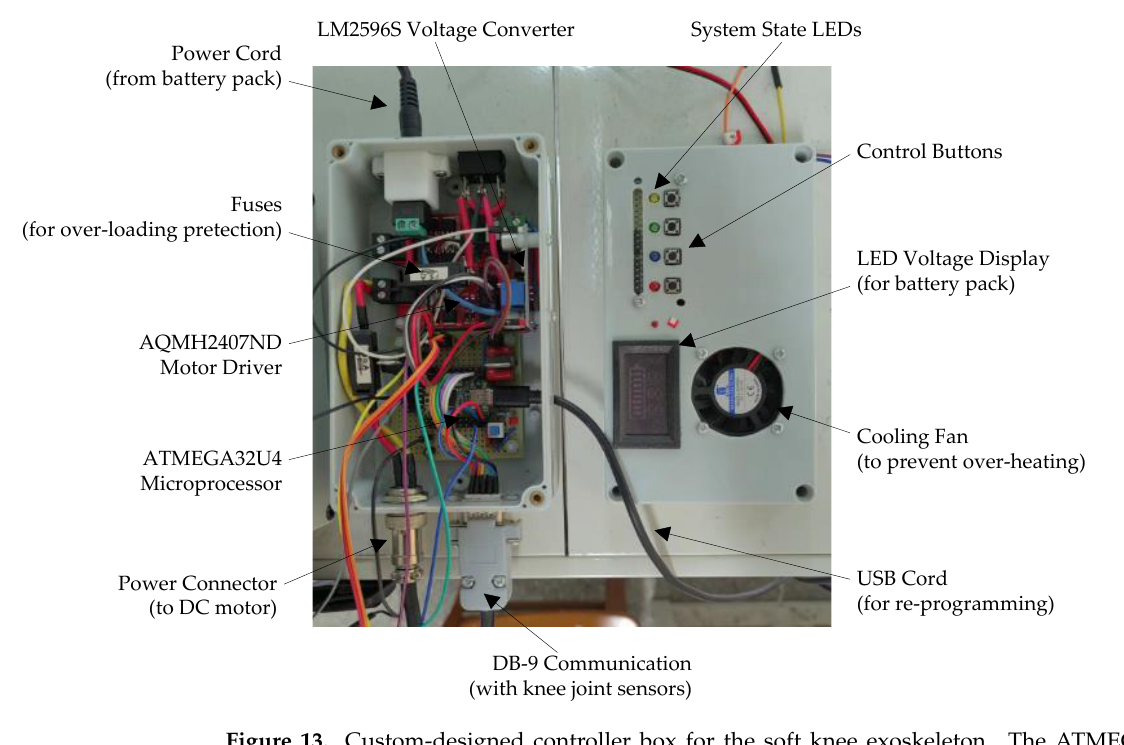
Figure 13. Custom-designed controller box for the soft knee exoskeleton. The ATMEGA32U4 microprocessor is used for the embedded implementation of the proposed control algorithm, and the AQMH2407ND motor amplifier is used to drive the DC motor.